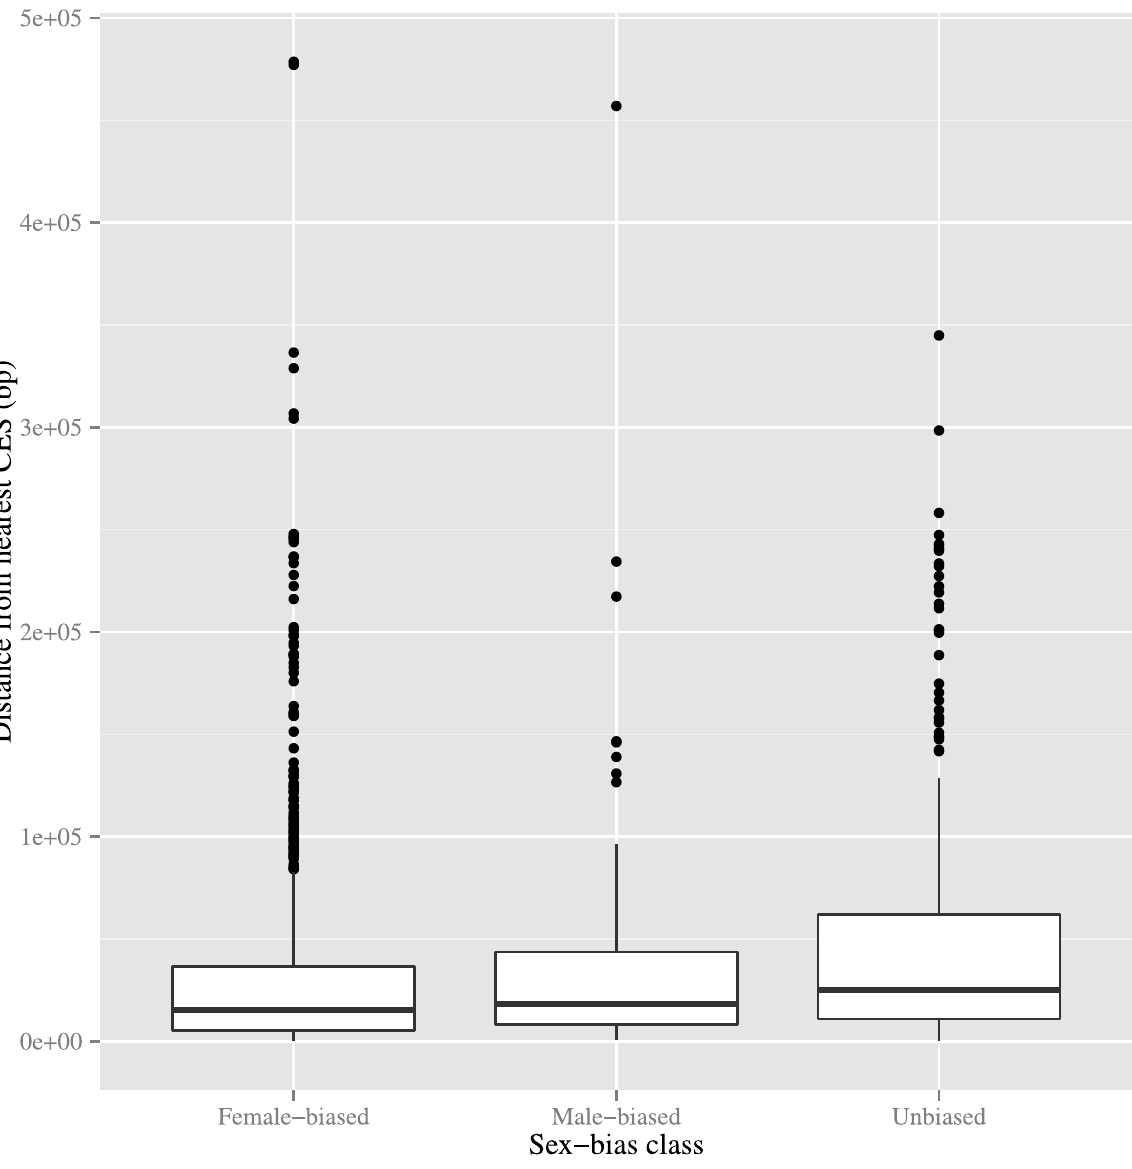
Figure 3. Distances of X -linked, non-testis-biased genes from nearest chromatin entry site, stratified by sex-bias class. Each X -linked gene, excluding those whose expression is biased towards testis, is classified by its expression pattern as female-biased (left), male-biased (middle), or unbiased (right). The boxplots represent the distances of genes within each class from their nearest chromatin entry site. No significant difference in mean distance is observed between the male-biased and female-biased classes. Interestingly, the male-biased genes appear to be significantly closer to the nearest CES than their unbiased counterparts ( t ~{ 2 : 83, p v 0 : 006 ).